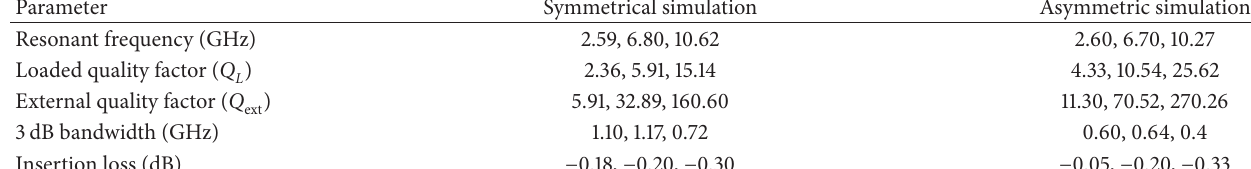
Table 1: Performance of the symmetric and asymmetric TBBSF.